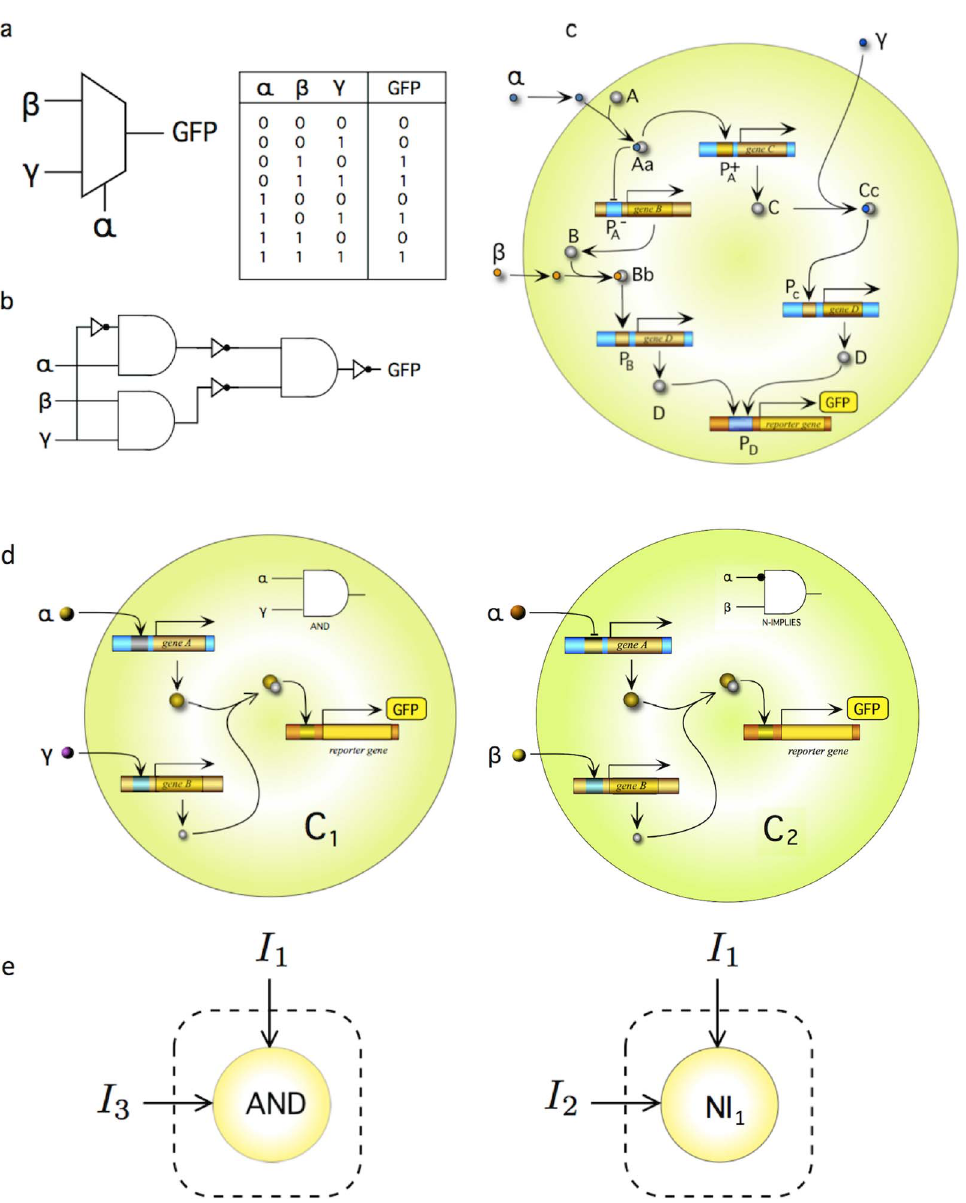
Figure 2. Standard and non-standard circuit design. Combinatorial circuits are constructed in conventional electronic design by using predefined gates and wiring them in order to execute a given input-output table. This is illustrated by the so called multiplexer (MUX) circuit, whose representation and logic table is shown in (a). Using AND and NOT gates, a standard implementation is displayed in (b). In (c) we show an example of a synthetic gene network implementing a single-cell multiplexer. The output signal is a GFP reporter. A very different design of the MUX system is shown in (d). Here the circuit can be easily designed by splitting the computation into two separated and disconnected engineered cells, both able to display the output signal. A simplified diagram that summarized the logic of (d) is shown in